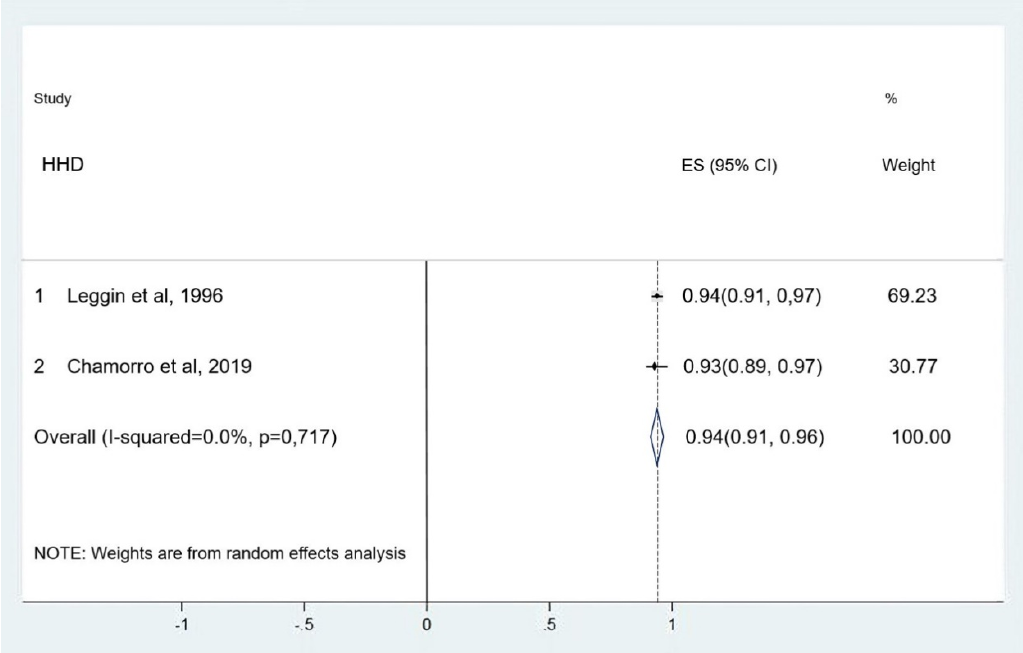
Figure 4. Meta-analysis of concurrent validity for shoulder internal rotator strength assessment . Shoulder External Rotators